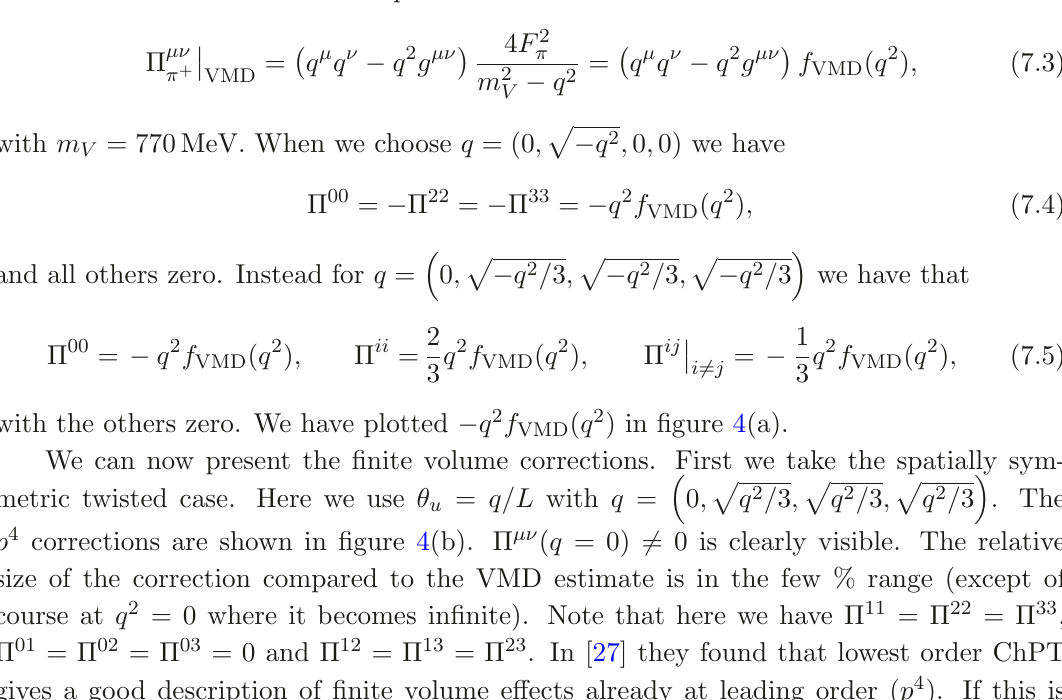
Figure 3 . (a) The vacuum expectation value θ u = (0 , θ, 0 , 0). (b) Same but only the up valence quark twisted. In both cases the x -component or µ = 1 is plotted, the others vanish. The p 4 line is essentially indistinguishable from the p 4 + p 6